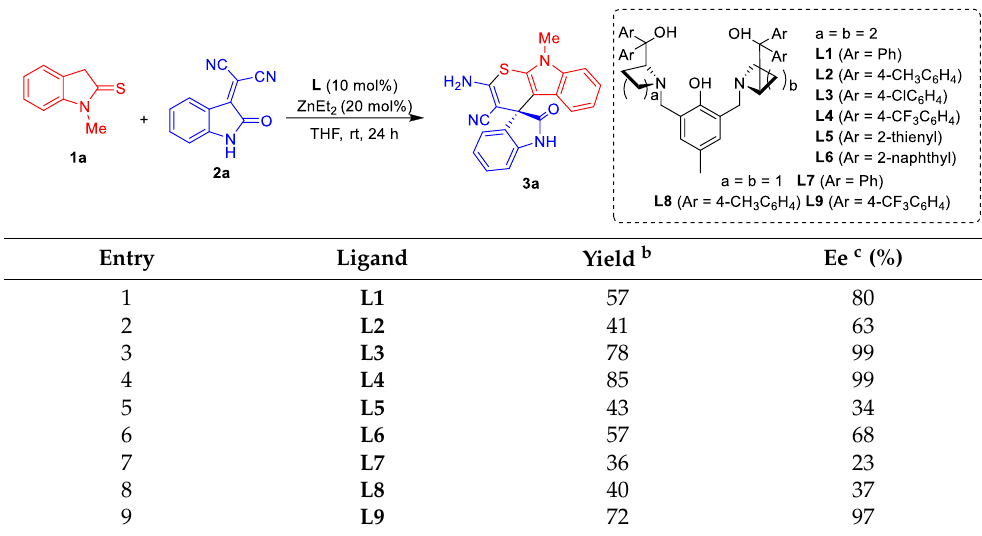
Table 1. Condition Optimization a .